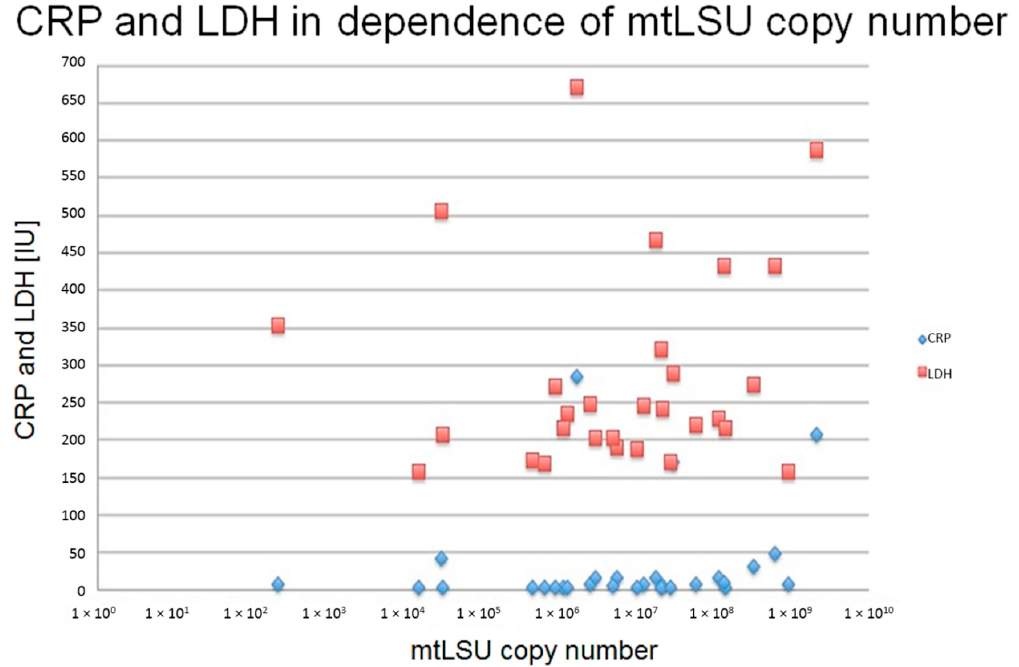
Figure 1. The figure shows the correlation between LDH, CRP, and the copy number of mtLSU from BAL fluids. LDH is elevated with dependence of the copy number, i.e. , the more mtLSU copies, the higher the LDH concentration. This effect was not present for CRP. The Pearson coefficient was 0.231, r 2 was 0.0534, both indicating a positive statistical correlation. However, the correlation is statistically significant only for CRP but not for